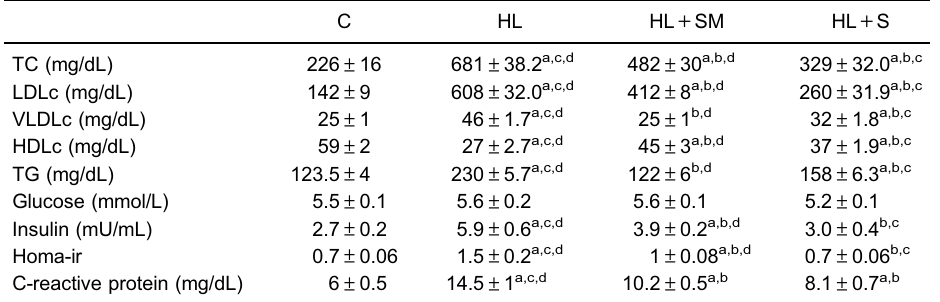
Data are reported as means ± SE for n=10 in each group. C: control group; HL: hyperlipidic diet-fed group; HL + SM: hyperlipidic diet-fed group treated with soy milk; HL + S: hyperlipidic diet-fed group treated with simvastatin; TC: total cholesterol; LDLc: low density lipoprotein cholesterol; VLDLC: very low density lipoprotein cholesterol; HDLc: high density lipoprotein; TG: triacylglycerol. a P o 0.05 vs C; b P o 0.05 vs